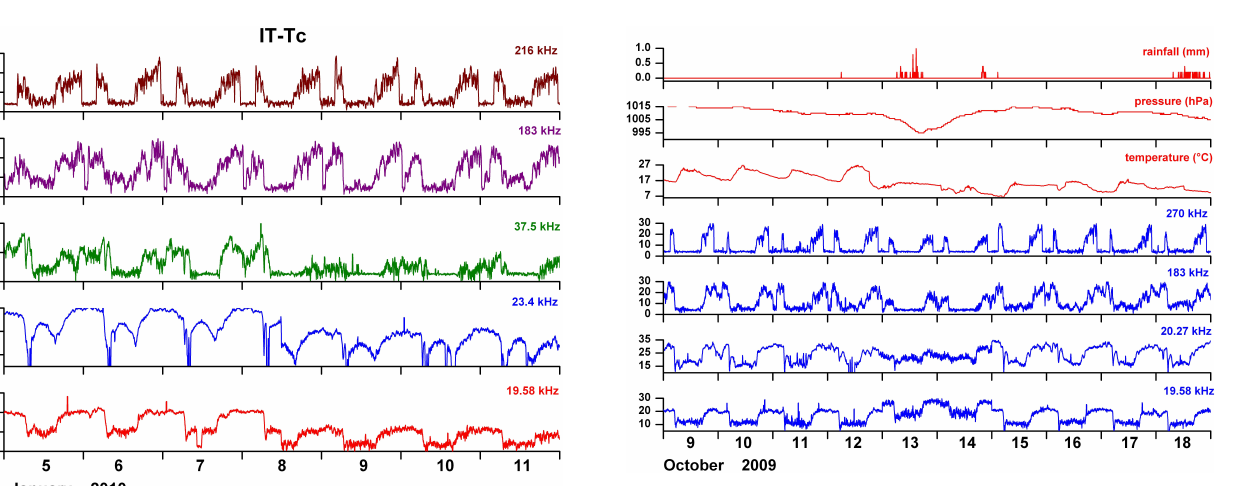
Fig. 8. Trends of the intensity of the MCO (216kHz), EU1 (183kHz), NRK (37.5kHz), DHO (23.4kHz) and GBZ (19.58kHz) radio signals collected by IT-Tc receiver during 5–11 January, 2010. Starting from January 8, a decrease appears on VLF (NRK, DHO, GBZ) signals, while no modification appears on LF (MCO, EU1) signals.